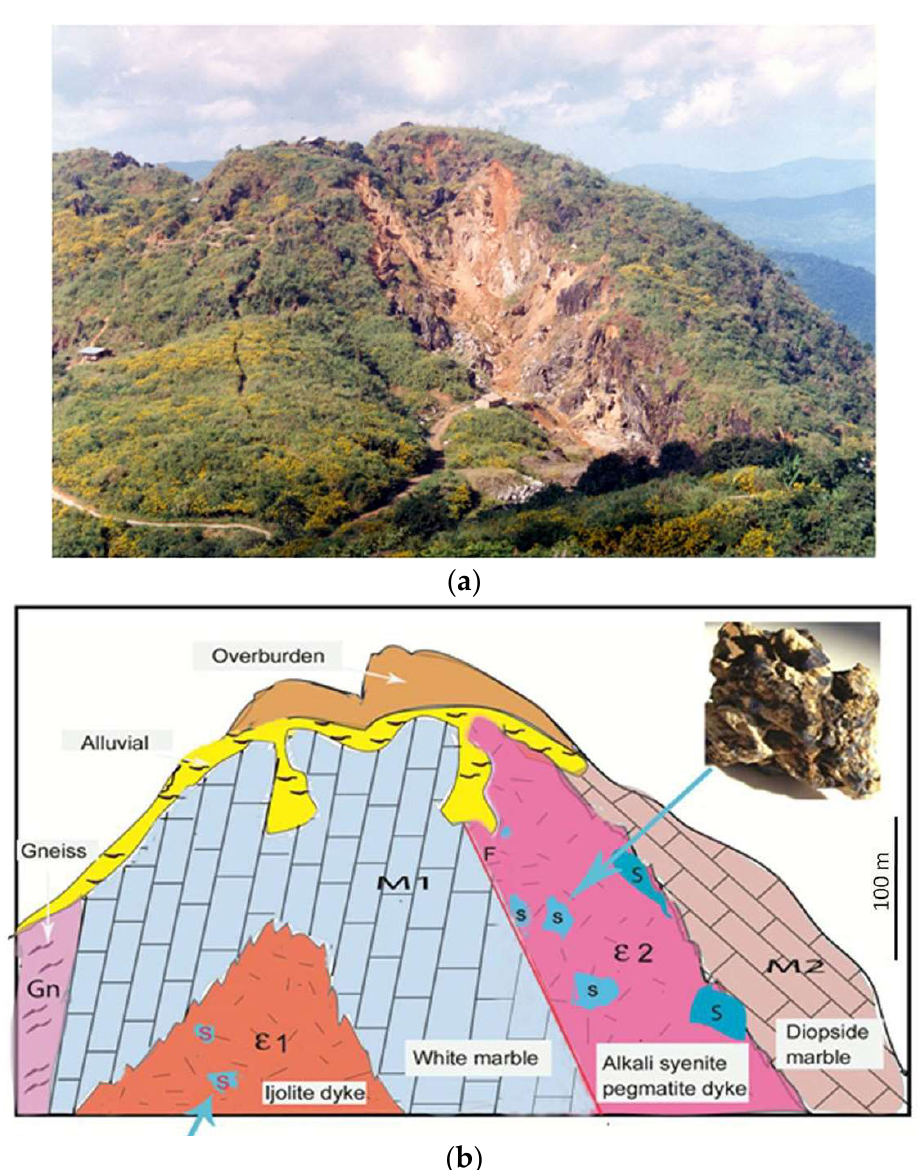
Figure 3. Thurein Taung ruby locality: ( a ) Hill exposing gem workings and scene for underlying geology section. Viewed from the east. Basal distance across view is ~600 m; ( b ) Sketch diagram across geological units (symbols and labels). V/H = 1, M1 = White Marble, M2 = Diopside marble, Gn = Gneiss, ε 1 = ijolite dyke, ε 2 = alkali syenite pegmatite dyke. Sapphire-bearing lithologies intrude the marbles (blue arrows), with sapphire deposits (s, inset). Ruby is associated with skarn near the top of the hill. Images; Kyaw Thu.